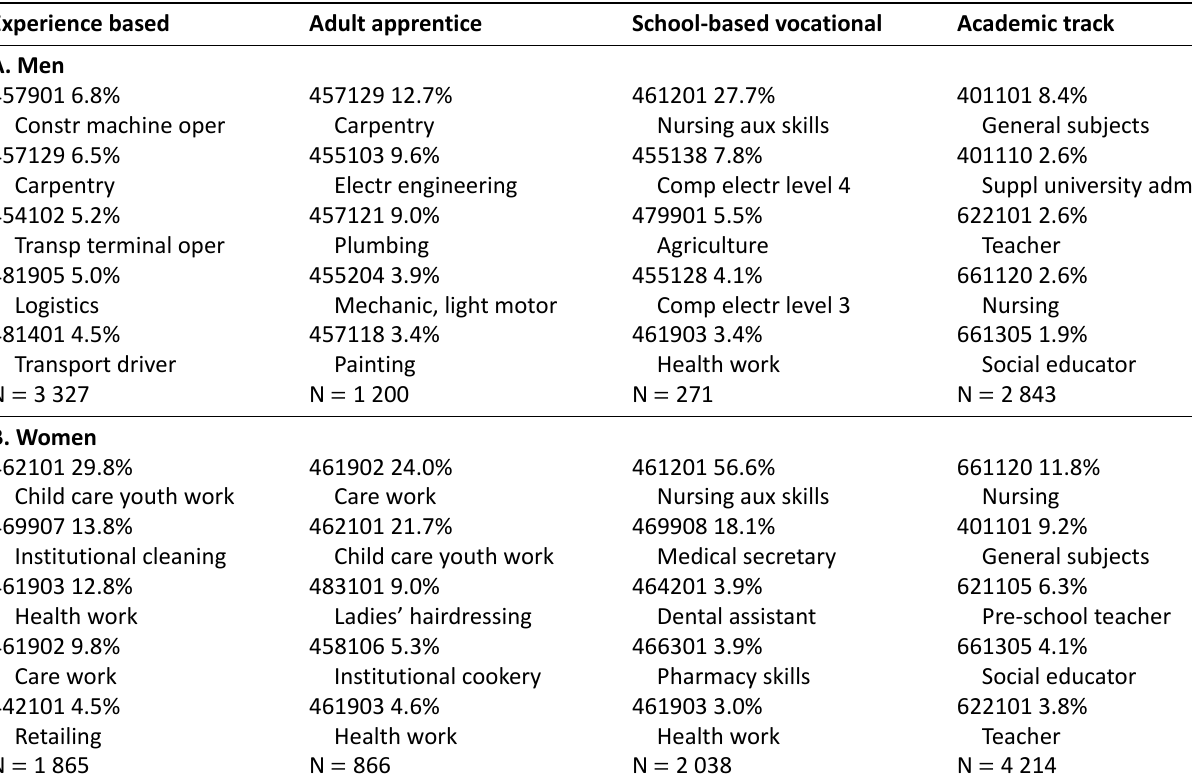
Table A1. Top five fields of study by adult route to completion of upper secondary education.